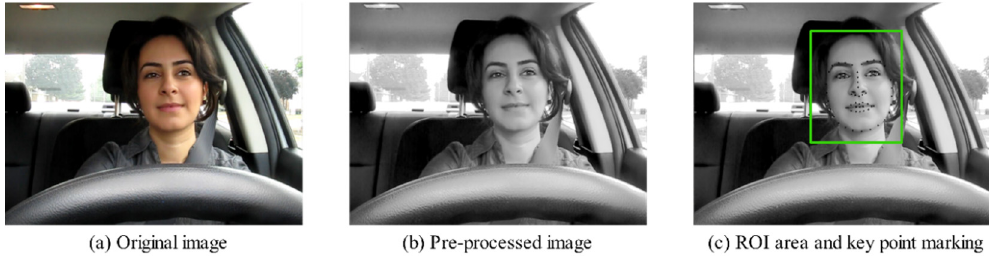
Figure 2. Image pre-processing and face detection.